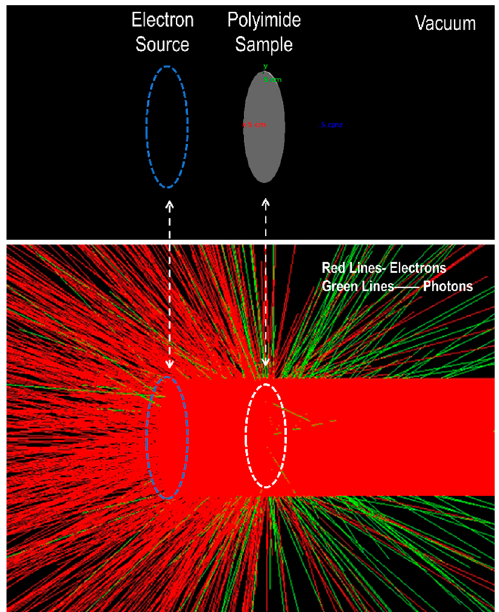
Figure 12. Simulation of electric field strength under 0.3 MeV high-energy electron radiation. Through the joint simulation method under 0.3 MeV high-energy electron radiation, the internal electric field distribution of PI sample with a diameter of 10 mm and a thick- ness of 1 mm was obtained under three beam currents of 5 µA, 10 µA and 15 µA. The internal maximum electric field strength is shown in Figure 13.